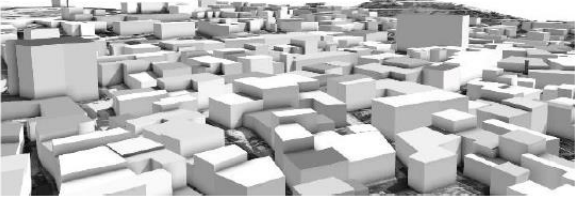
Figure 6. Representation of LoD 100 of Norcia in Infraworks